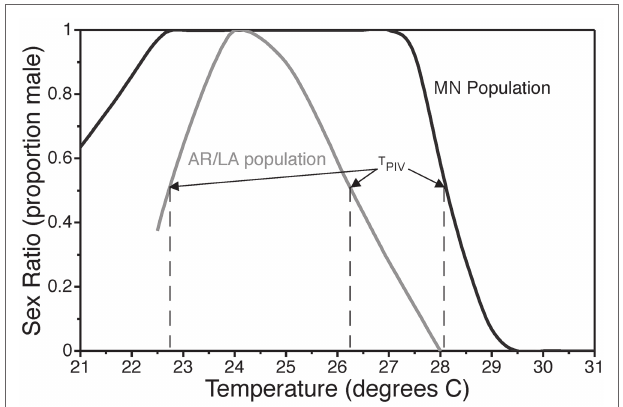
FIGURE 3 | Thermal reaction norm for sex determination in common snapping turtles, Chelydra serpentina , from Minnesota and the Arkansas/ Louisiana border. The constant incubation temperature that produces a 1:1 sex ratio is called the pivotal temperature T PIV . Data are modified from Ewert et al.,